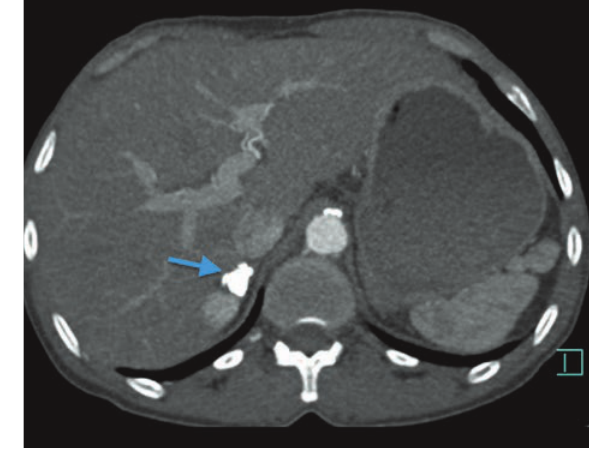
Fig. 12. A 48-year-old man with a background history of disseminated TB. Axial contrast-enhanced CT scan demonstrates dense calcification of the right adrenal gland (blue